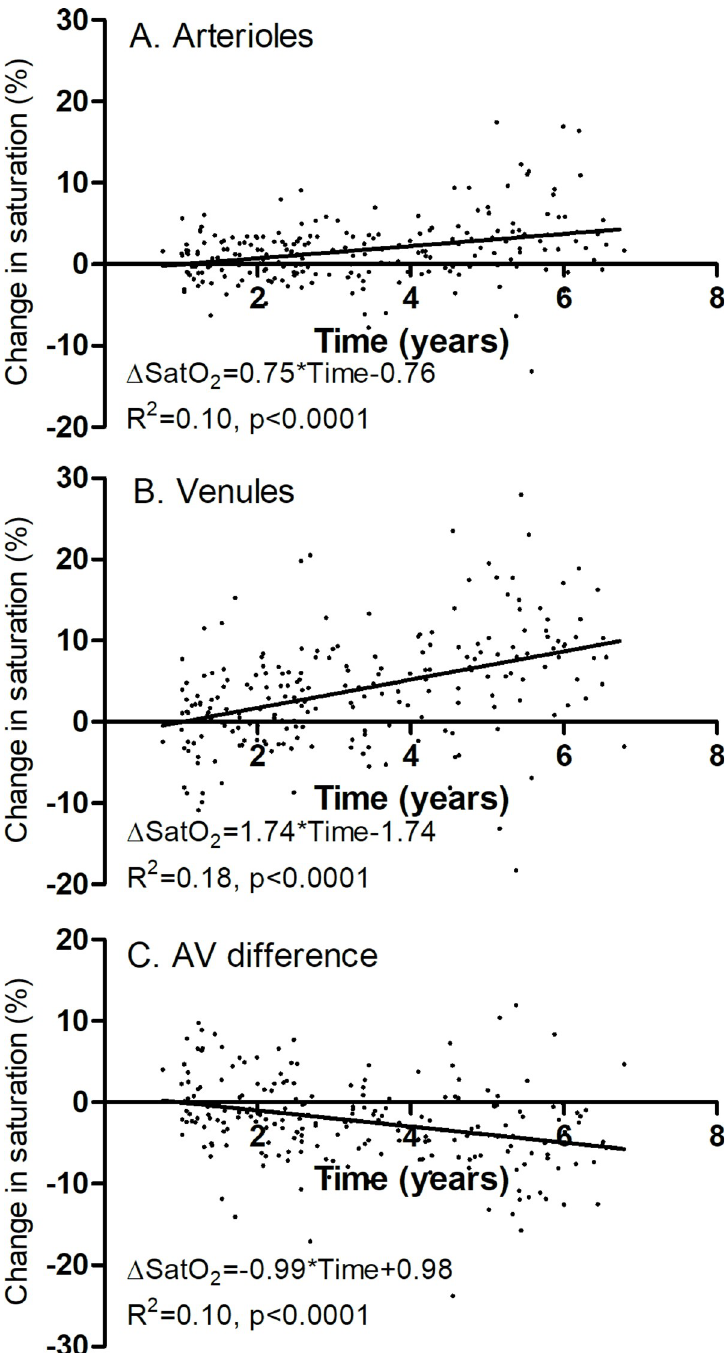
Fig 2. The change in oxygen saturation. Change from baseline to follow-up visit, plotted against the time of follow- up. Each point denotes one patient (n = 214). A. Saturation in retinal arterioles increased by 0.75 percent per year of follow-up (p < 0.0001). B. Saturation in retinal venules increased by 1.74 percent per year of follow-up (p < 0.0001). C. The arteriovenous difference in saturation decreased by 0.99 percent per year of follow-up (p < 0.0001).